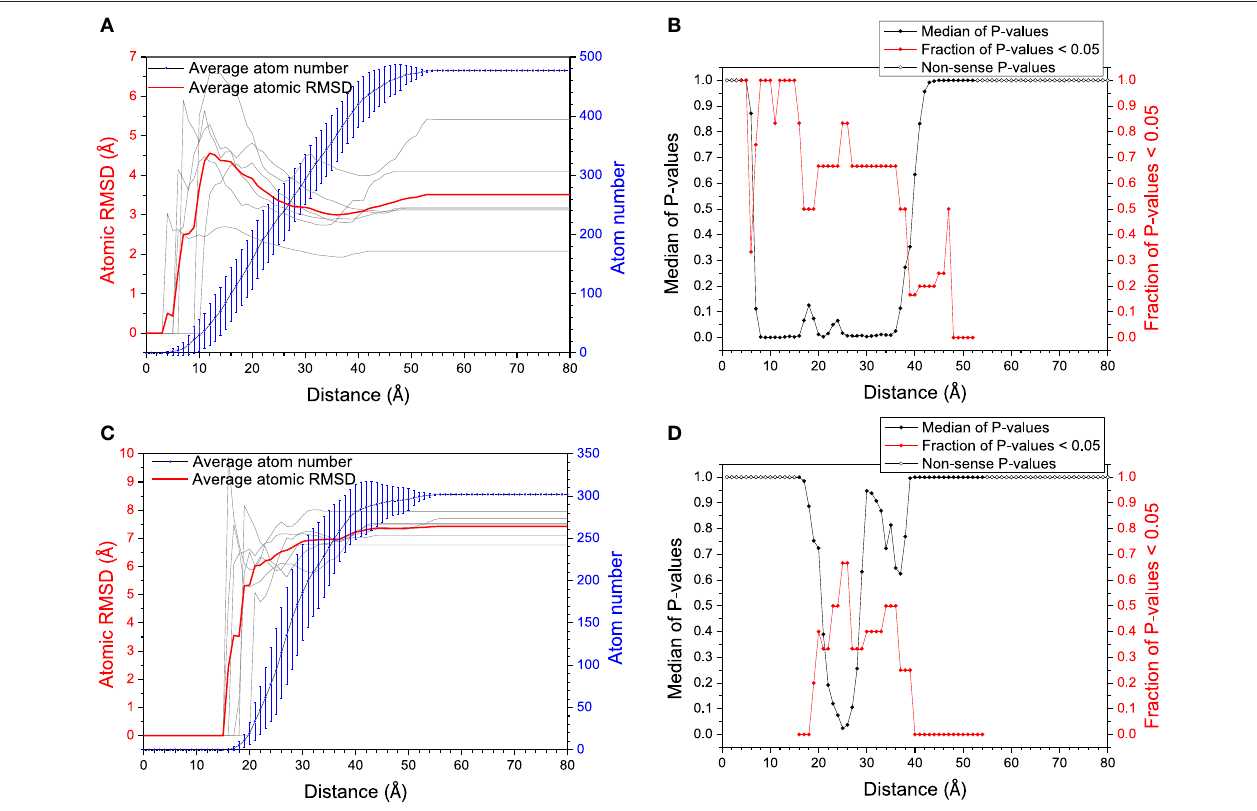
FIGURE 2 | RMSD (between bound structure and its most similar apo-structure) vs. distance from the mass center of the polymerase (A) and the DNA/RNA hybrid (C). Larger RMSD in short distance (larger conformational change around binding site) reflects larger magnitude of mechanism of induced fit. The significance of the conformational change between within every distance from the binding site and within the whole molecule was tested by KS P -test, for DNA/RNA hybrid (B) and the polymerase (D) , respectively.